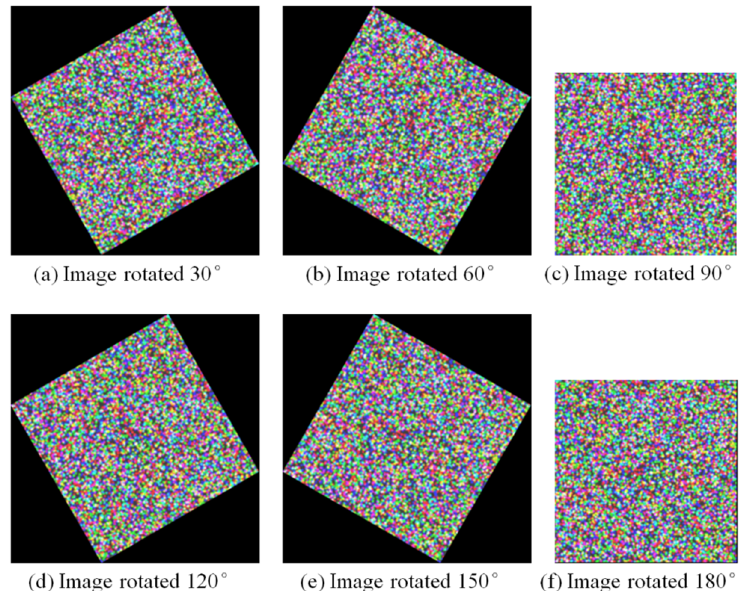
Figure 7. A set of simulated images with different rotation angles. Table 1. Measurement results of the deformed images with different rotation angles.